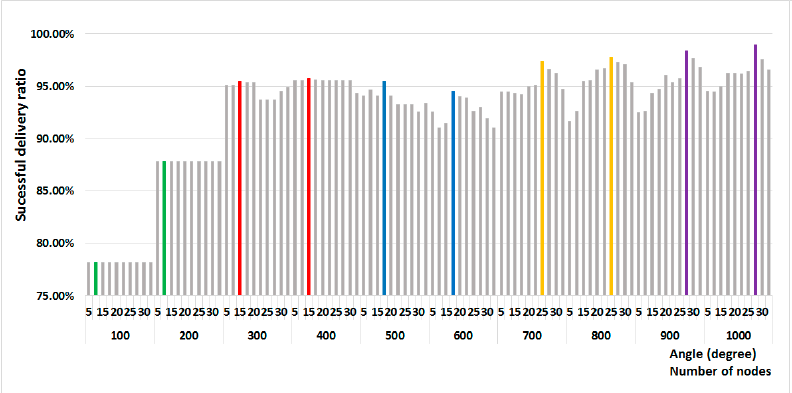
Figure 15. Successful content delivery rate vs. the optimal suppression angle. Information 2018 , 9 , x